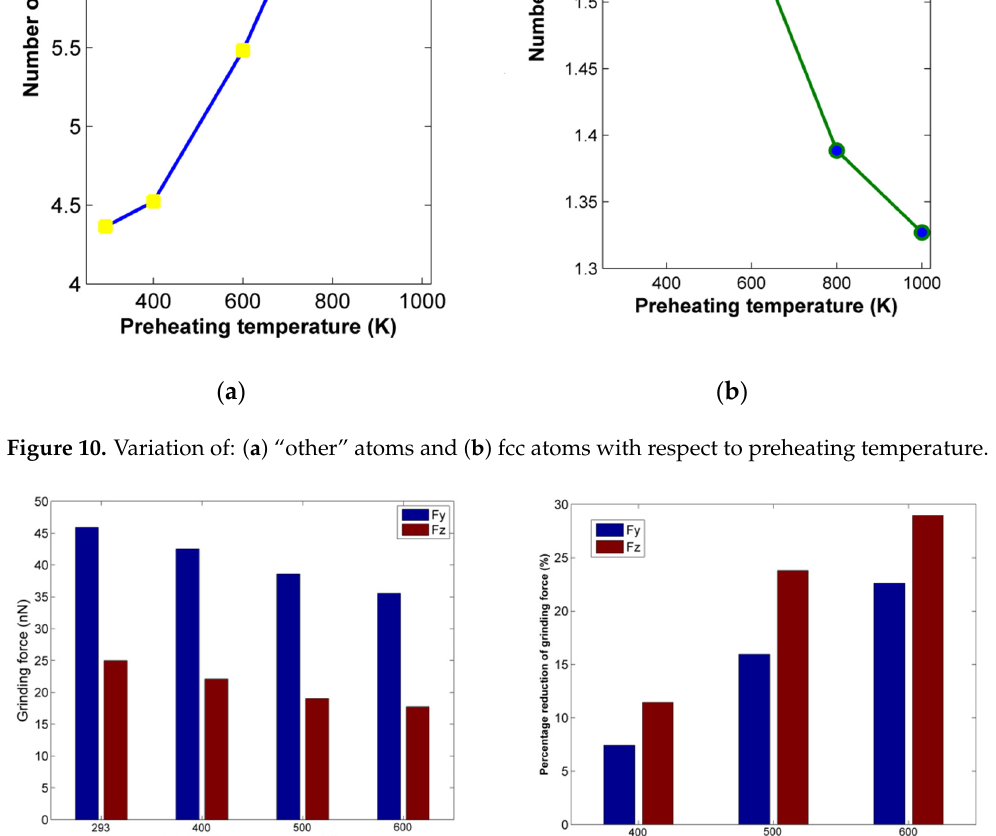
Figure 10. Variation of: ( a ) “other” atoms and ( b ) fcc atoms with respect to preheating tempera- ture.